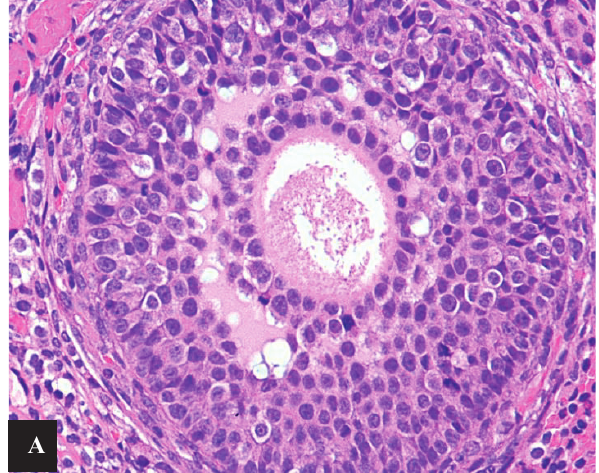
Fig-2A: Photomicrograph showing normal structure of secondary follicle of Control group A (H&E,20x)